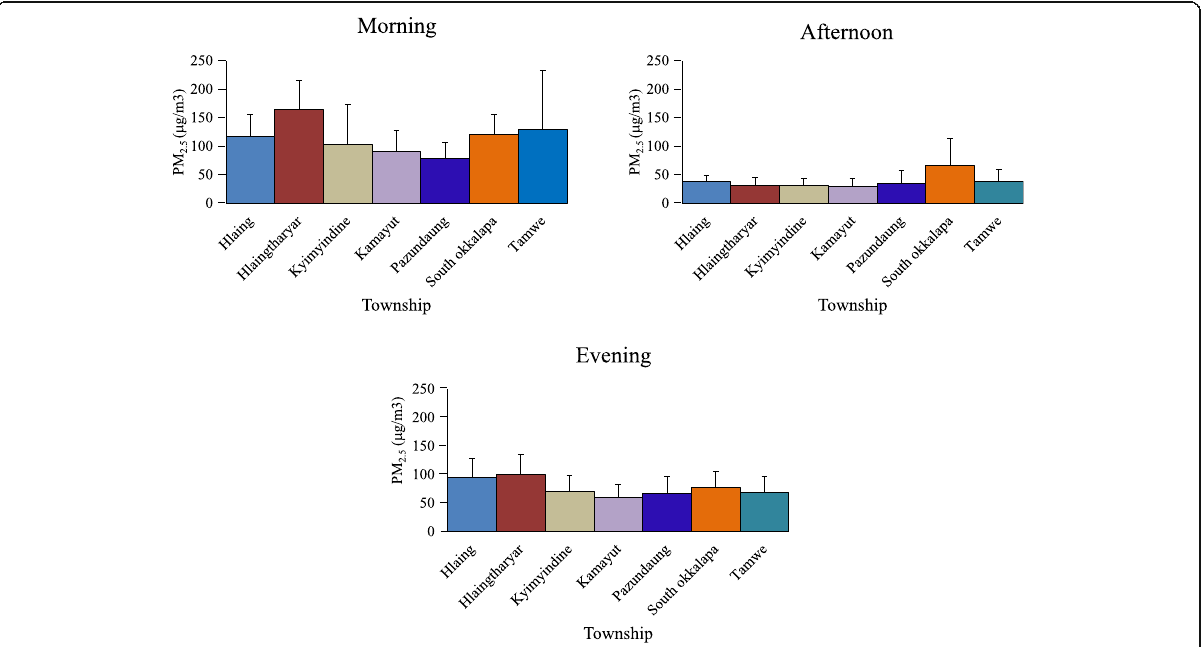
Fig. 4 Distribution of PM 2.5 concentration in seven townships, Yangon, Myanmar. The concentrations of PM 2.5 in seven townships (Hlaing, Hlaingthayar, Kamayut, Kyimyindine, Pazundaung, South Okkalapa, and Tamwe) of Yangon City were measured. The investigators walked along the road sides of these areas of the city for three times a day (from 7:00 to 7:15 h, from 13:00 to 13:15 h and from 19:00 to 19:15 h). Each bar represents the